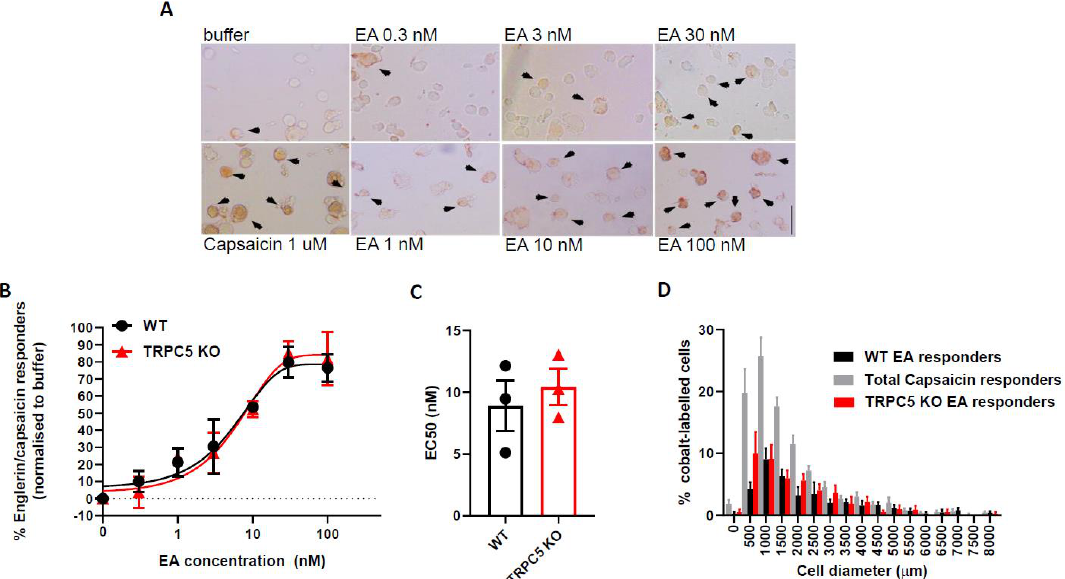
Figure 4. Englerin-A induces cobalt uptake in cultured primary sensory neurons. ( A ) Representative images of cobalt- labelled primary sensory neurons (brown; indicated by black arrowheads) obtained from dorsal root ganglia from WT or TRPC5 −/− mice, stimulated with ascending concentrations of Englerin-A (scale bar 200 µm; magnification 10×). Capsaicin (1µM) and buffer alone were used as positive and negative controls respectively. ( B ) Dose-response curve of cultured primary sensory neurons from WT (black; n = 3) and KO (red, n = 3) mice to Englerin-A ( C ) Comparison between EC50 for Englerin A in WT DRG cultures (black) and TRPC5 KO DRG cultures (red). ( D ) Size-frequency distribution of cobalt- labelled DRG neurons from WT (dark grey, n = 690) and KO mice (red, n = 449) to Englerin-A (30 nM) stimulation and total capsaicin responsive neurons (light grey, n = 1453).